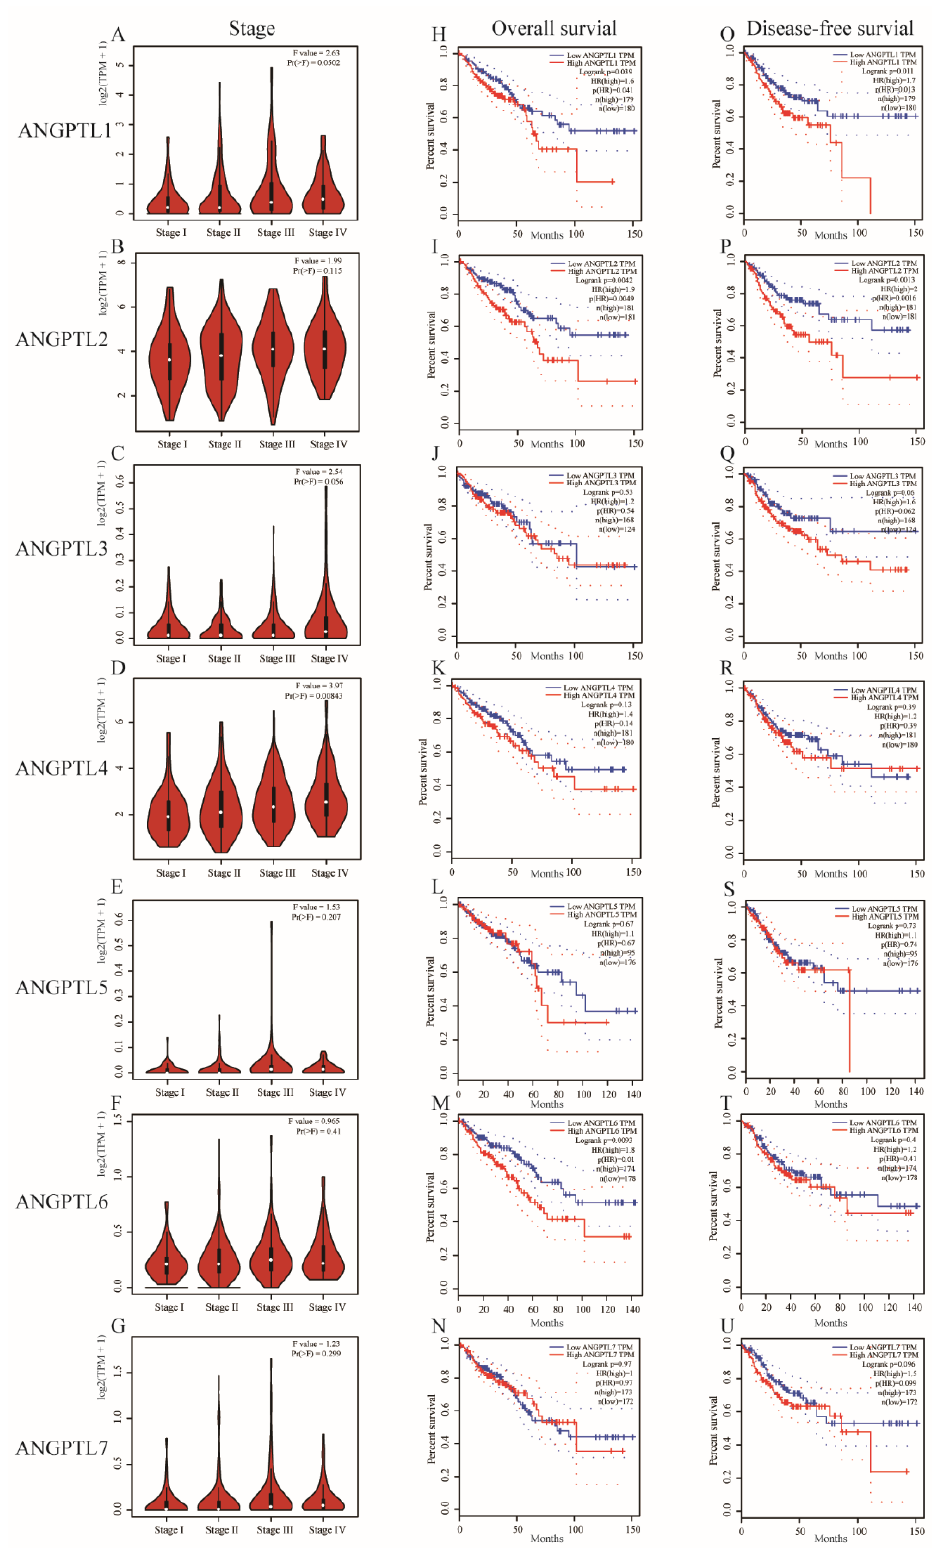
Figure 3. The prognostic value of ANGPTLs in CRC patients (GEPIA2). ( A – G ) Correlations between the expression of ANGPTLs and tumor stage in colorectal cancer patients. ( H – N ) The overall survival (OS) in colorectal cancer patients based on the expression of ANGPTLs. ( O – U ) The disease-free survival (DFS) in colorectal cancer patients based on the expression of ANGPTLs.